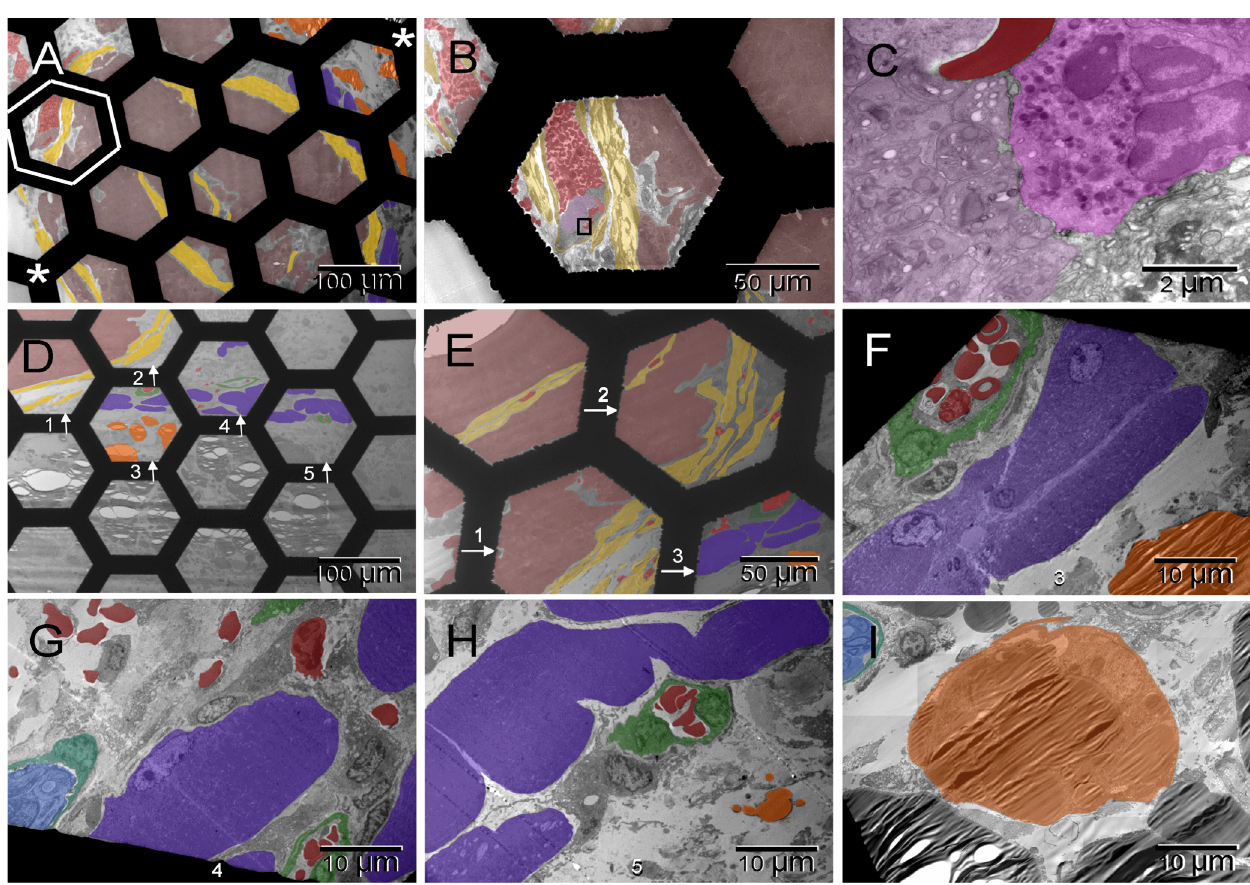
Figure S5. Histomorphology of the spheroid-derived tumors and the surrounding host tissues. The stars in [ A ] mark edges of the tumor (brown) facing glass of the chamber and the host tissues: muscles (dark purple) and fat (orange) underlying the host’s dorsal skin (lower left and upper right respectively). The field framed with white hexagon and enlarged in [ B ] contains the capsular vaso-mimicry separated from the larger tumor mass with a multi-cellular layer of fibroblasts (yellow). Fragments of that field are shown at higher magnifications in Figure 1 [ I ] and here in panel [ C ] where a cluster of platelets can be recognized (light purple region on the left) next to a neutrophil (pink on the right). A larger region of the host tissues between the tumor and skin is shown in [ D ]. Fields 1–3 are enlarged in [ E ]. [ F – H ] focus on muscle cells from fields 3–5 accompanied by vessels (green), nerve (blue) [ G ] and lipid droplets (orange) [ F & H ]. The adipocyte in [ I ] is from a region not shown at low magnification. None of the hexagonal fields enclosed by the grid bars was completely filled with the tumor cells indicating that the size of individual nodules roughly matched the oxygen diffusion range (100–200 µm 58